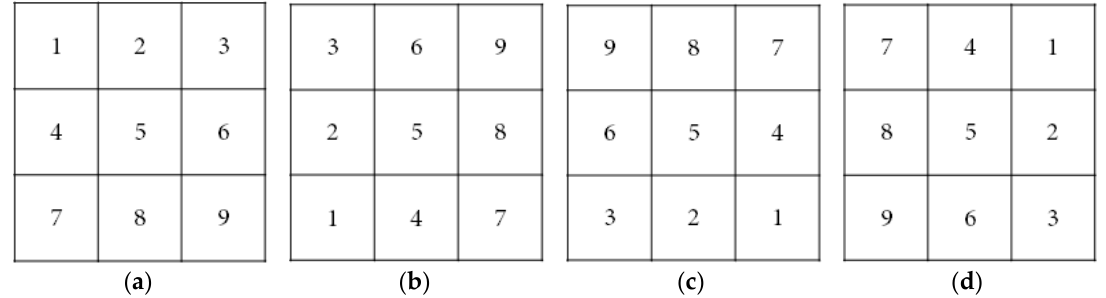
Figure 4. Binary coding order of different angles in a block. ( a ) 0°; ( b ) 90°; ( c ) 180°; ( d ) 270°.